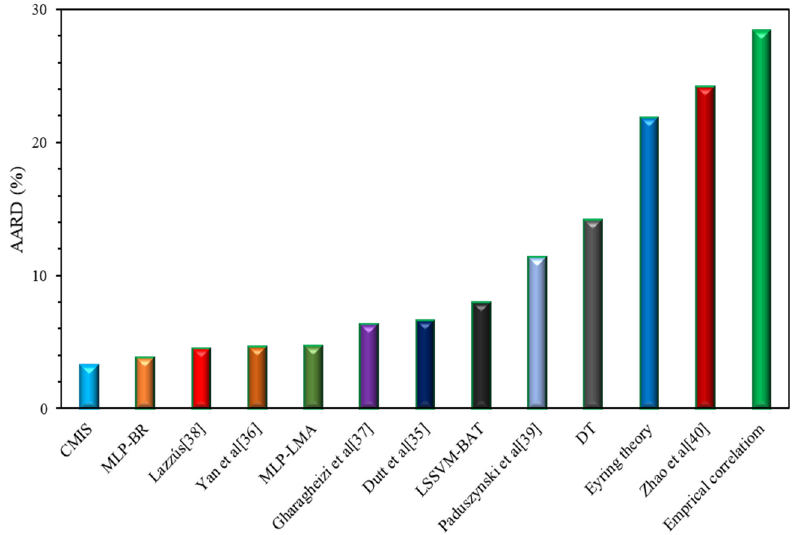
Figure 7. Comparison between absolute average relative deviation (AARD, %) of different models for estimation of viscosity of ILs based on Model (II).